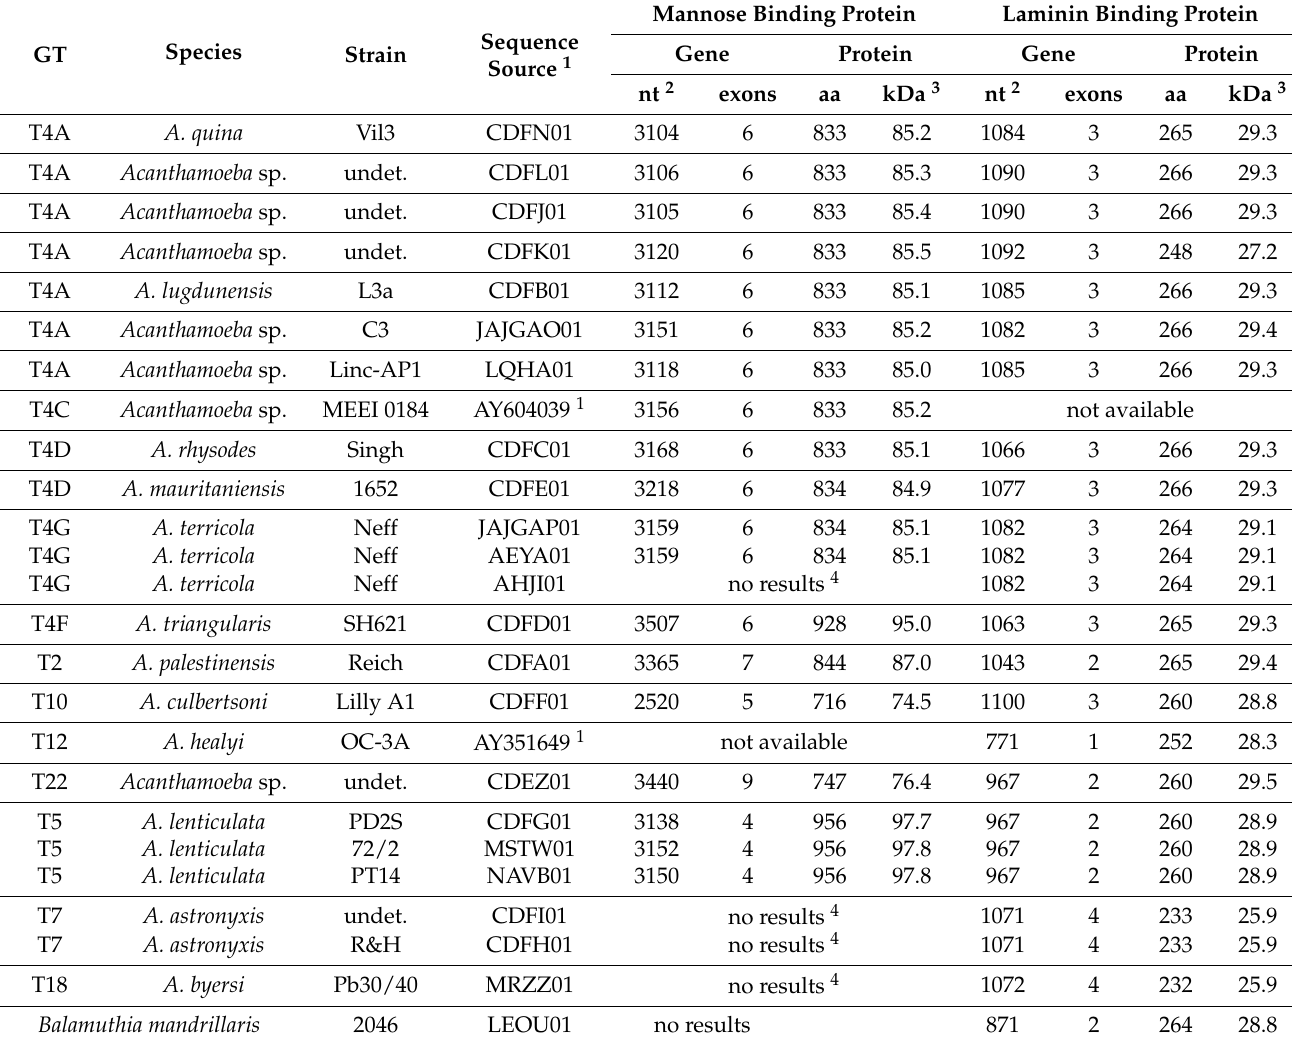
Table 1. Summary of Acanthamoeba binding proteins